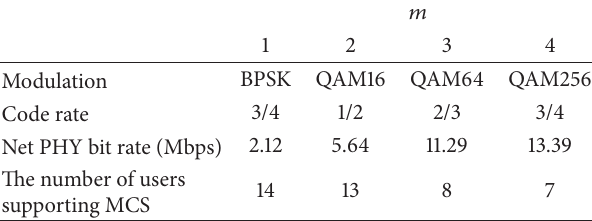
Table 1: MCS and number of users supporting